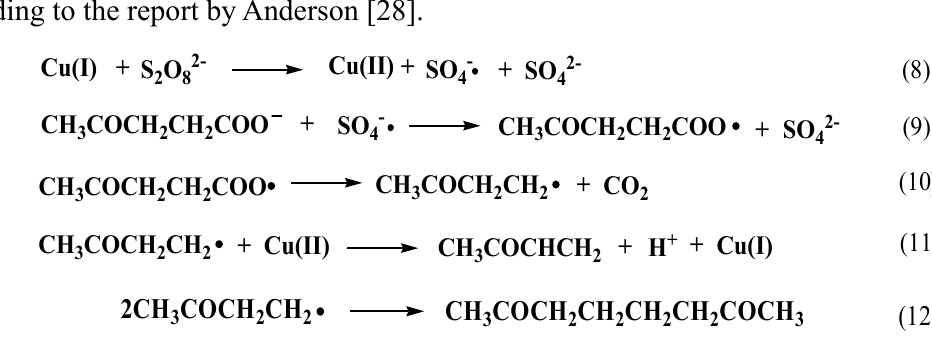
Figure 5. Headspace - gas chromatogram (A) and Ion Chromatogram (B) of samples.